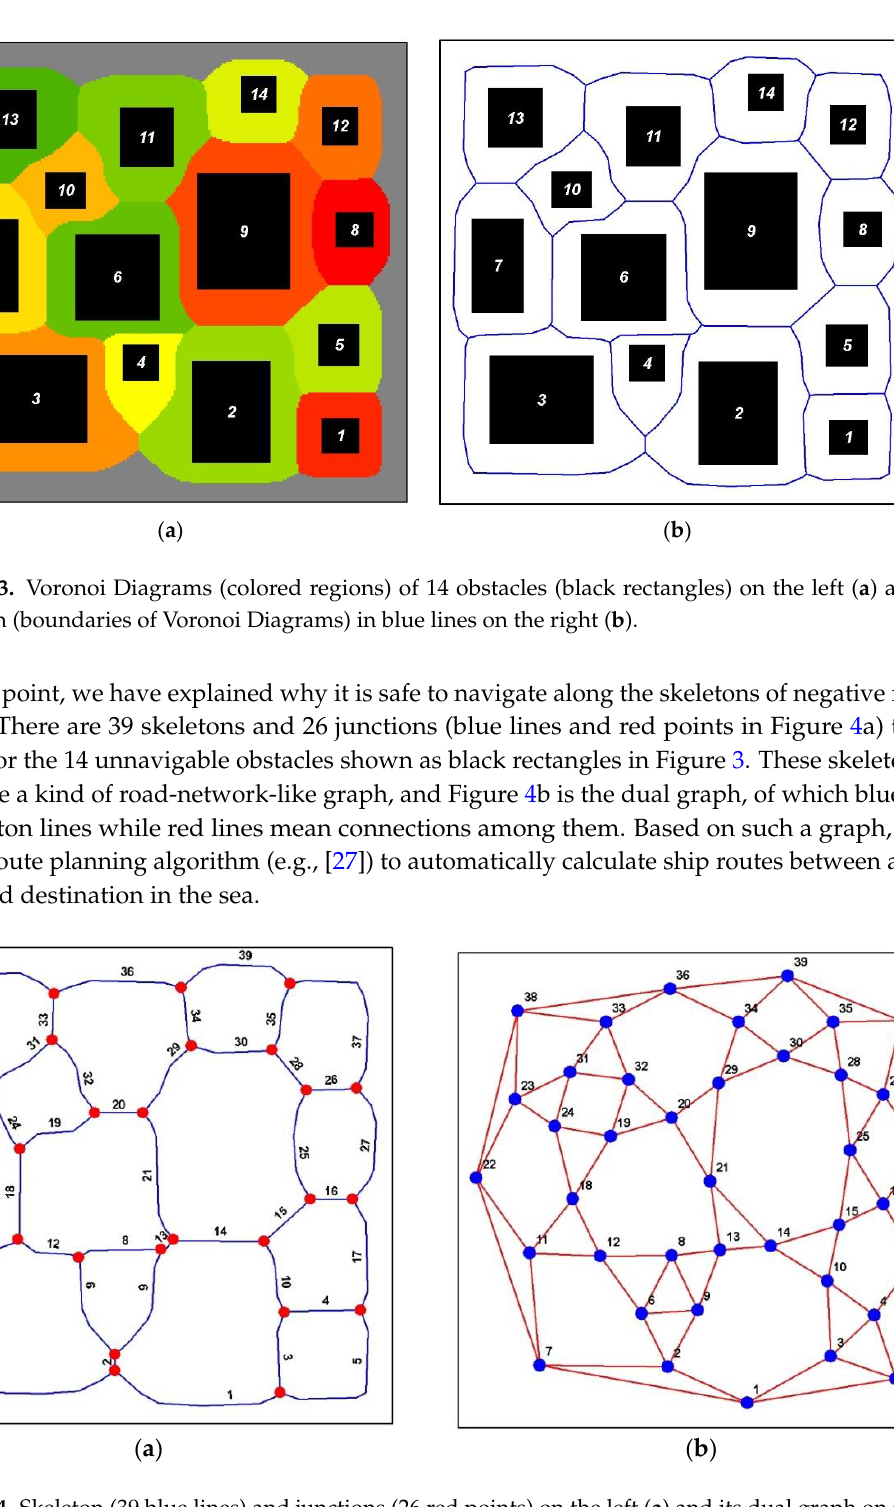
Figure 4. Skeleton (39 blue lines) and junctions (26 red points) on the left ( a ) and its dual graph on the right ( b ): blue points means 39 skeleton lines and 78 red lines means the connections. right ( b ): blue points means 39 skeleton lines and 78 red lines means the